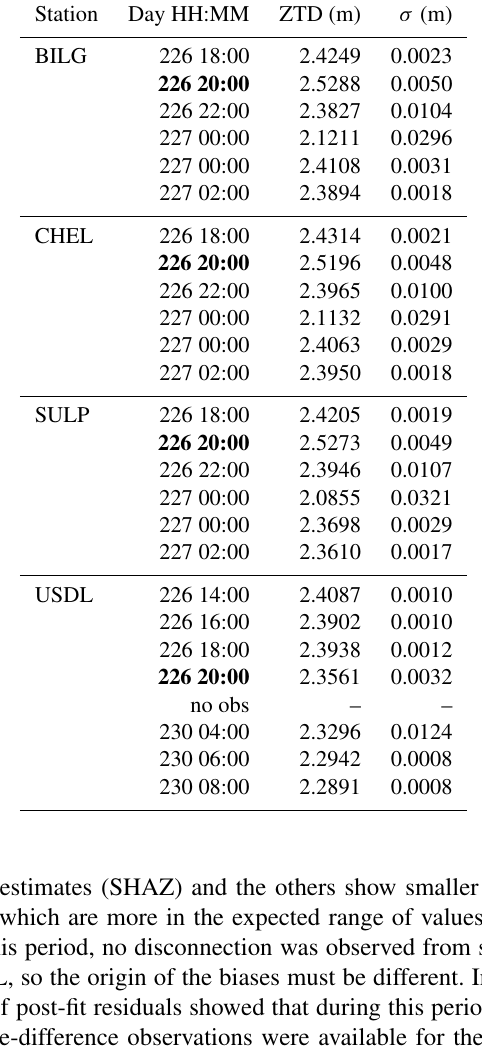
Table 1. Estimated ZTD and formal error ( σ ) at stations impacted by a gap in observations at reference station USDL at 20:00 on day 226 (see also Fig. 2). The terms in bold font highlight the start of the gap in observations at reference station SULP.